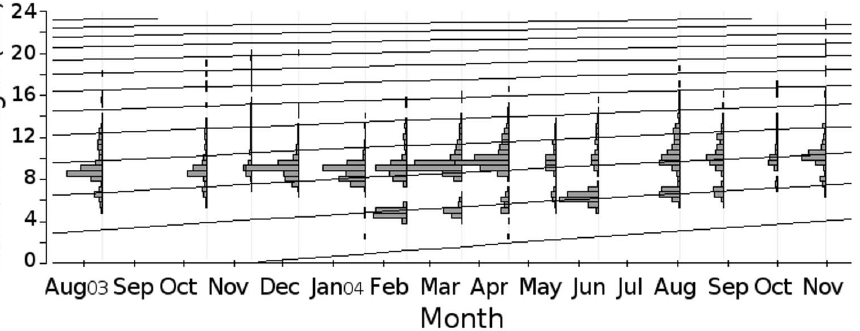
Figure 4. Body-growth function adjusted for C.spixii . Von Bertalanffy body-growth function for Cathorops spixii individuals sampled in Caraguatatuba Bight from August 2003 through October 2004, using the ELEFAN I routine. L ‘ (maximum length) = 27.3; K (growth-curve parameter) = 0.16; Rn (goodness of fit)=0.259.